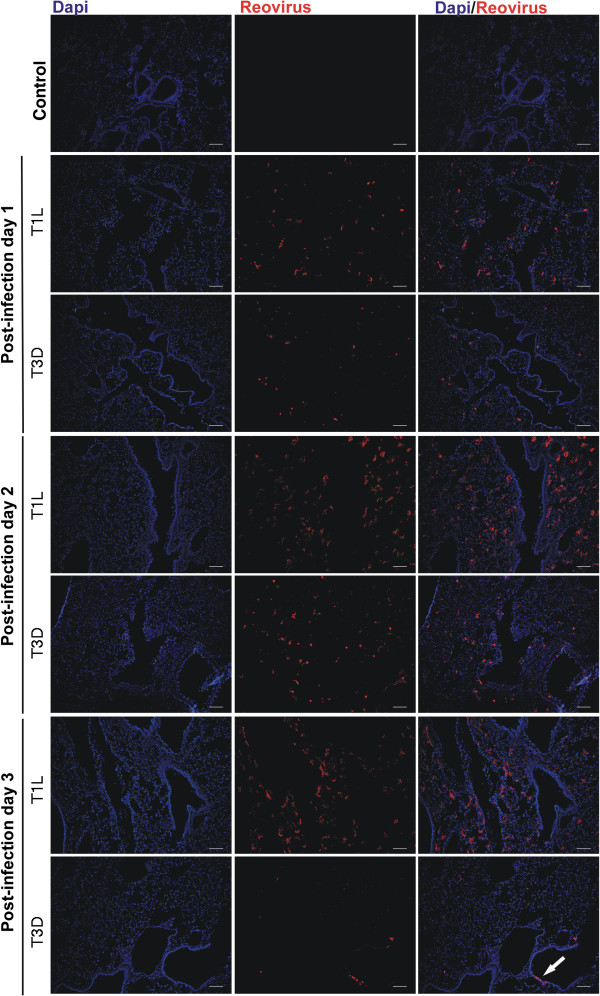
Time course of immunofluorescent staining of virus infected adult lungs. Groups of 2 adult mice were infected intranasaly with 107 pfu of either T1L or T3D before fluorescent antibody staining of frozen lung sections at 1, 2, or 3, days pi. T1L and T3D antigens were stained with virus specific antiserum as the primary antibody followed by CY3 labeled donkey anti-rabbit IgG and are colored in red. Cell nuclei were stained with DAPI and are shown in blue, either alone or merged with the CY3 stained images. Sagital sections show extensive staining in alveolar regions as well as sparse staining of epithelium in the bronchiolar airways (arrow) restricted primarily to T3D infection. Uninfected control lungs are shown as negative staining controls. Size bars are 100 μM.